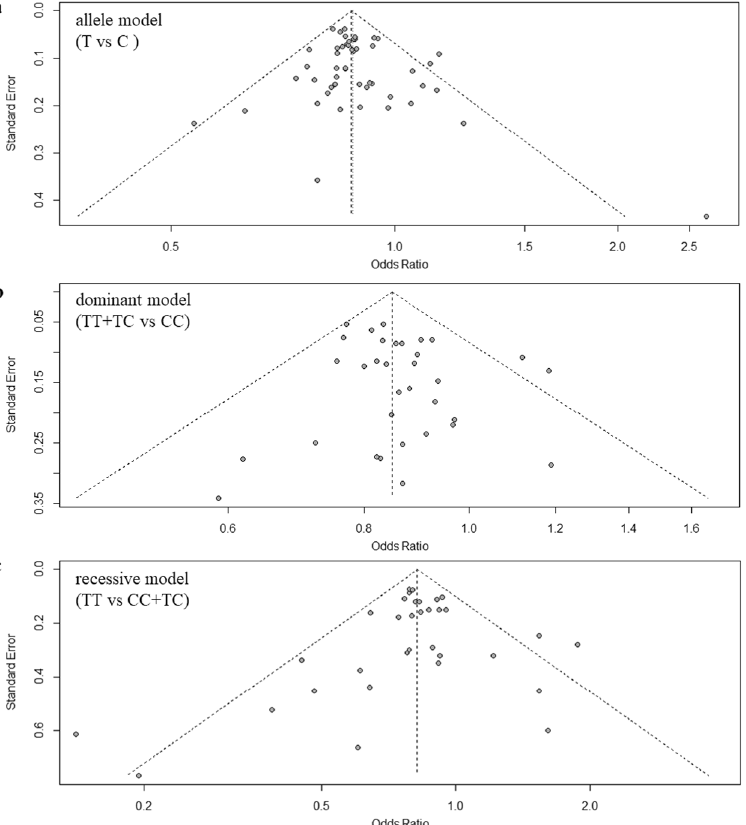
Figure 5. Funnel plot for publication bias analysis of rs11136000 polymorphism in AD using allele, dominant and recessive